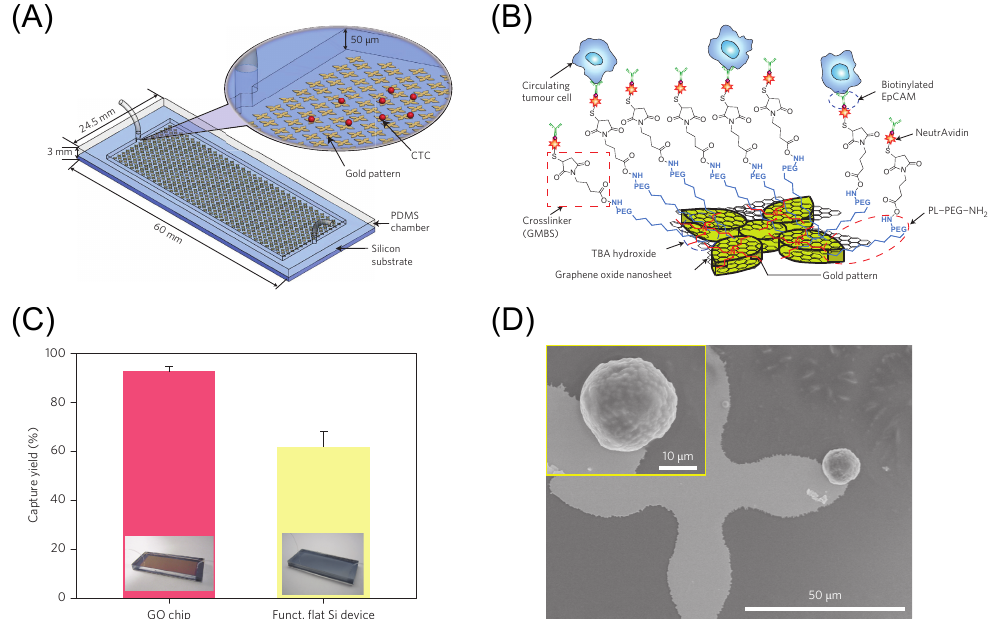
NATURE NANOTECHNOLOGY DOI: 10.1038/NNANO.2013.194